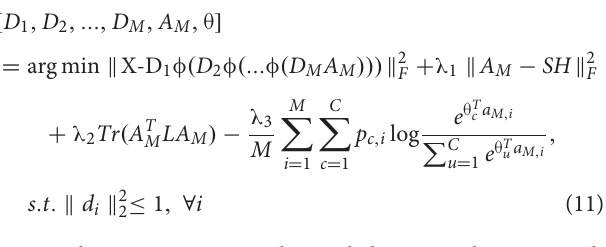
Frontiers in Neuroscience |